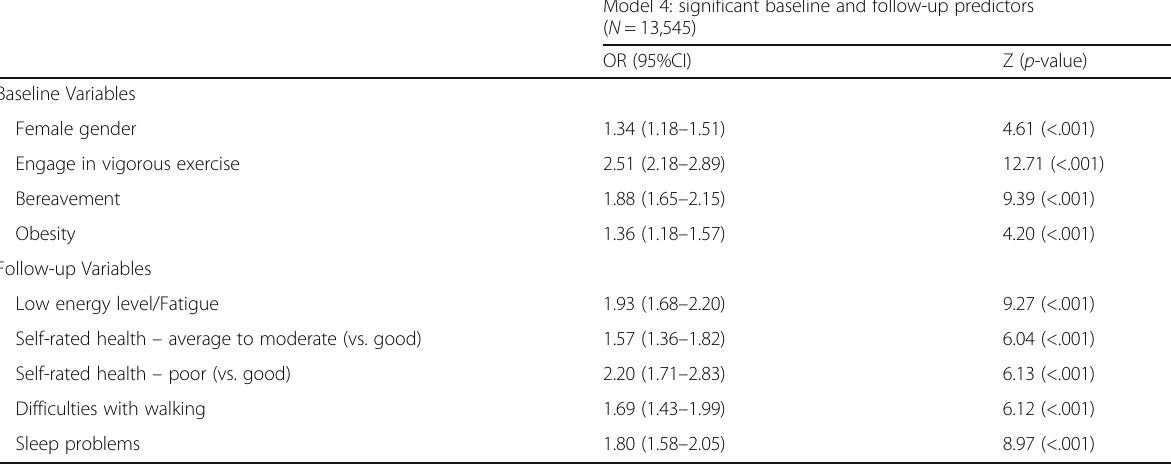
Table 3 Final hierarchical pain predictive model